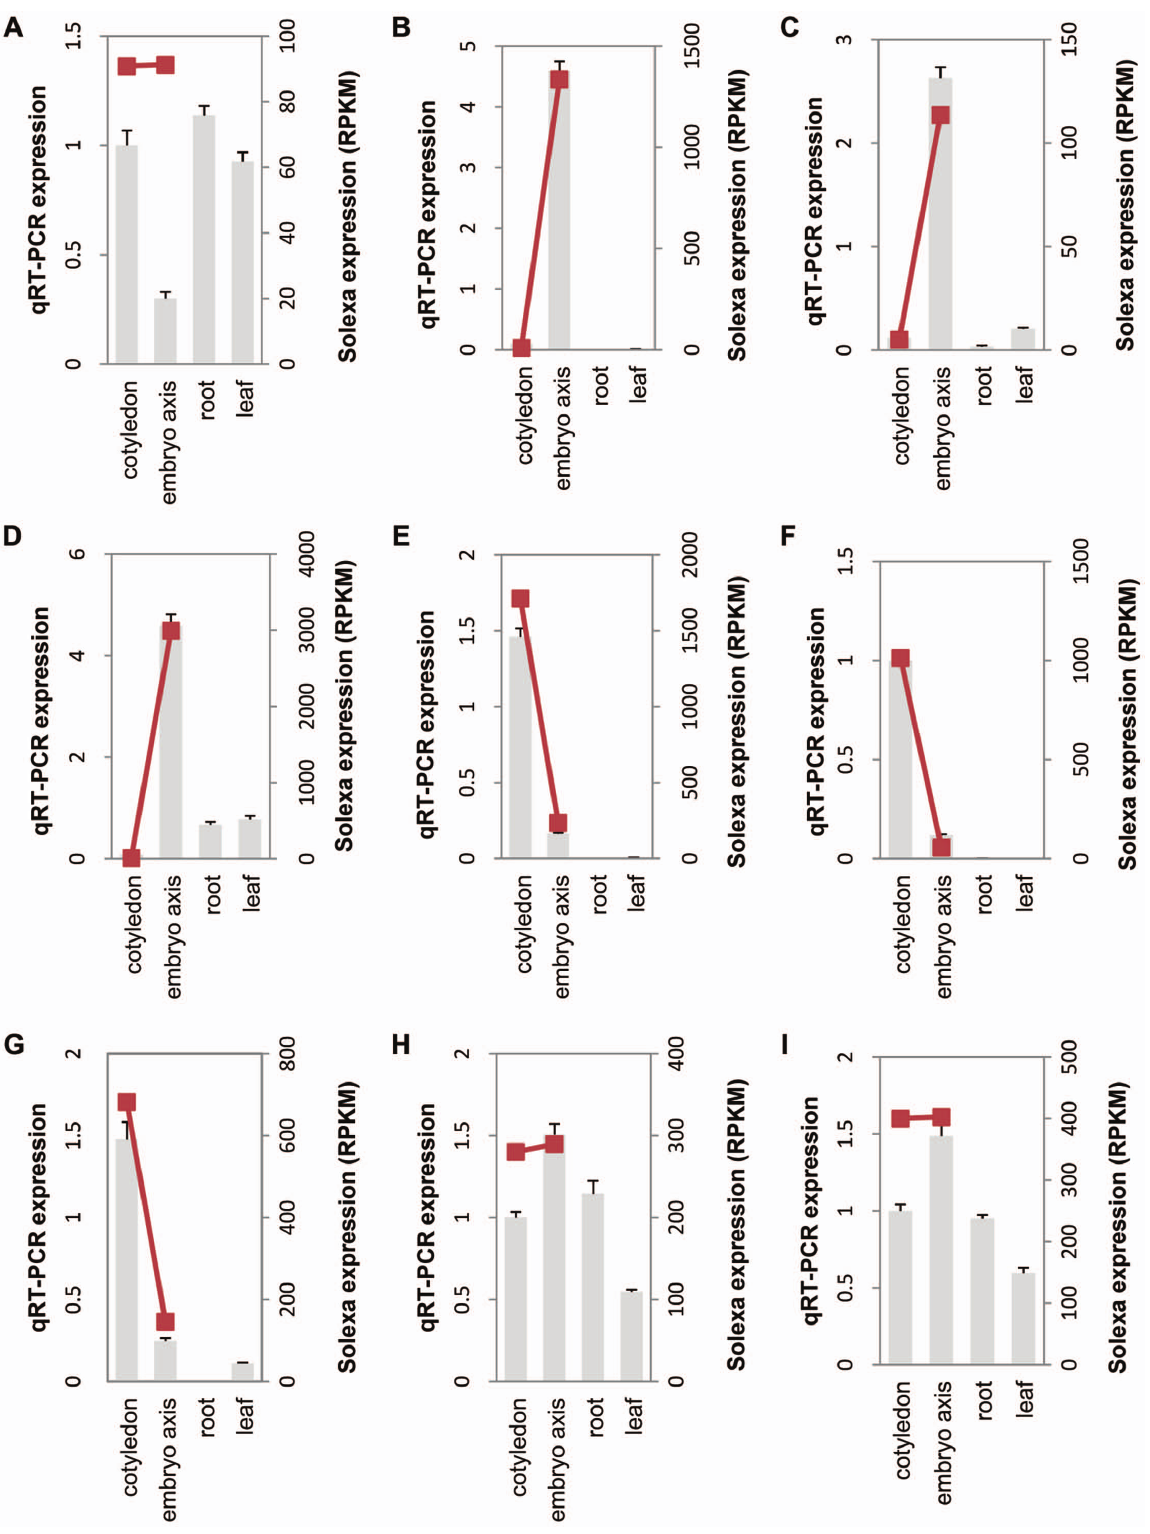
Figure 5. qRT-PCR validations of the selected unigenes. 9 unigenes were selected for qRT-PCR to validate the expression patterns in different samples. The grey bar represent the relative intensity of real time qRT-PCR from independent biological replicates (using the left Y axis), the red squares represent the expression level (RPKM) of the transcript (using the right Y axis) and are connected by the red trend lines. The unigenes are: A, unigene42855; B, unigene70917; C, unigene36175; D, unigene 72799; E, unigene4514; F, unigene37407; G, unigene25168; H, unigene29210 and I, unigene19199.